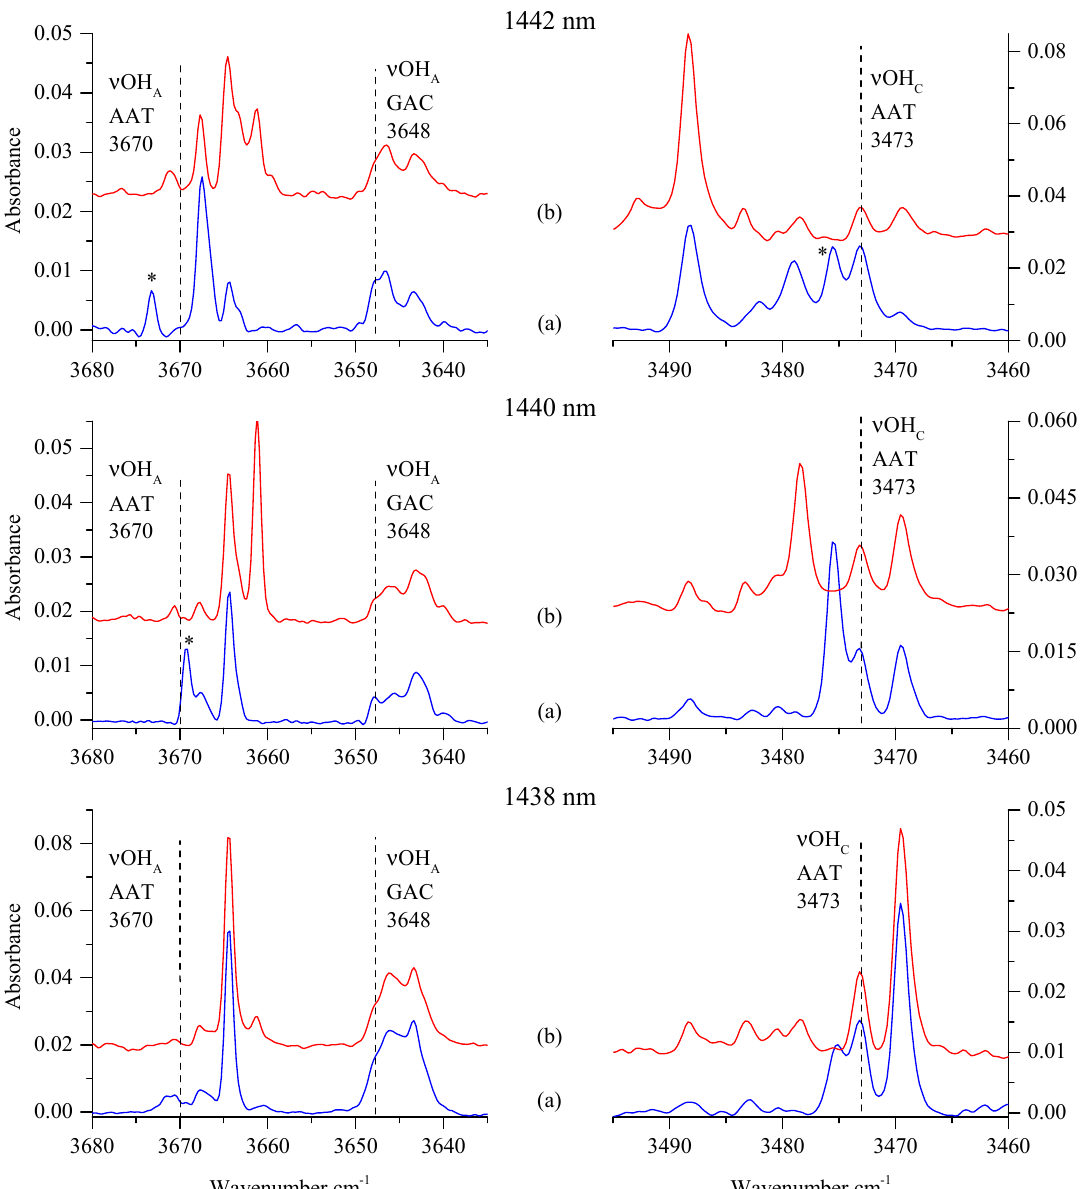
Figure 4. The ν OH regions of the infrared spectra of GAC and AAT complexes with nitrogen: ( a ) GA / N 2 / Ar deposited at 18 K / 10 K and after 360 min irradiation at 1438, 1440, or 1442 nm; ( b ) the same matrix upon annealing at 33 K / 10 K. The perpendicular broken lines show position of the GA monomer bands. Stars (*) denote bands disappearing upon annealing.